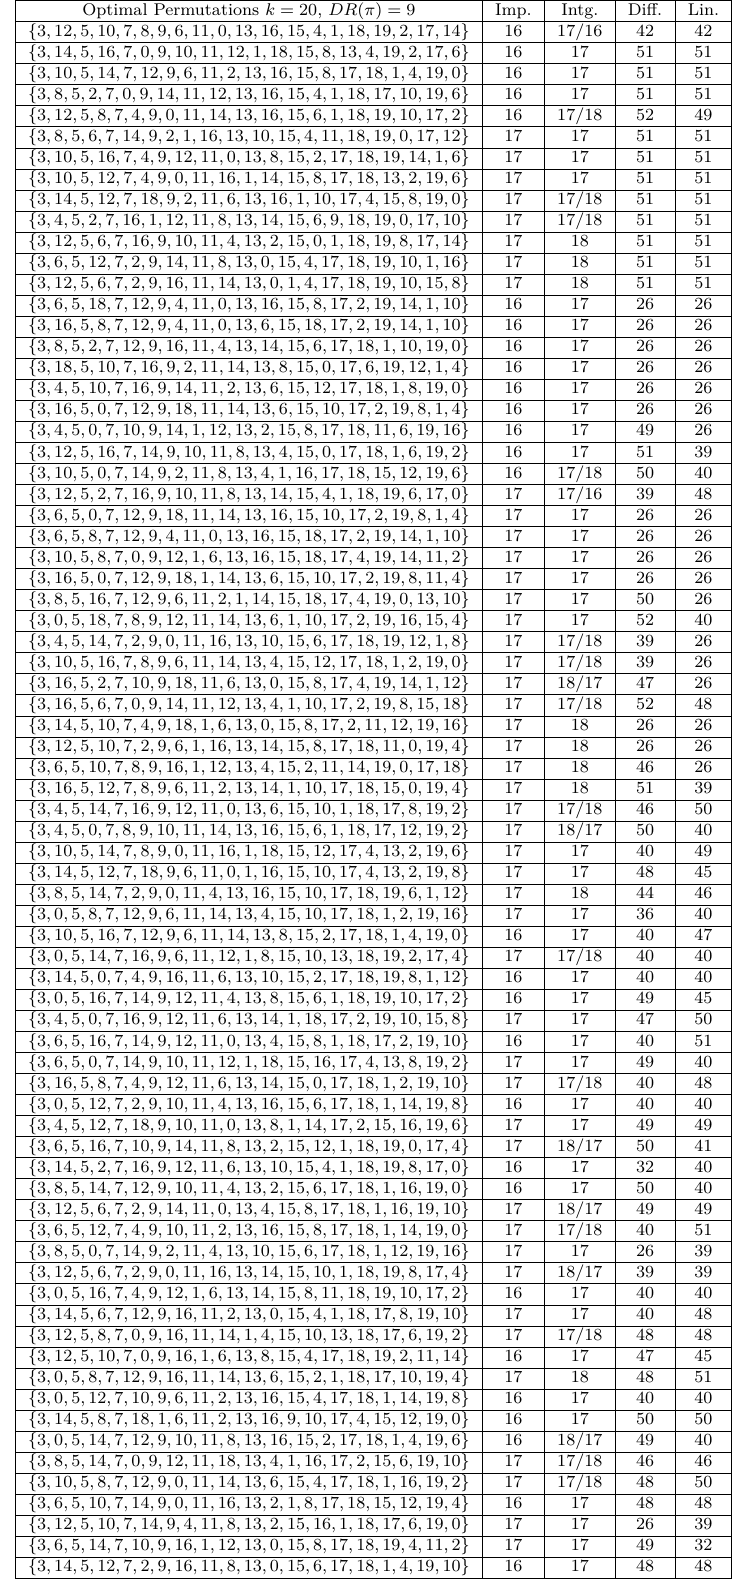
Table 18: Some optimal permutations for k = 20 up to extended pair-equivalence Optimal Permutations k = 20, DR ( π ) = 9 Imp.